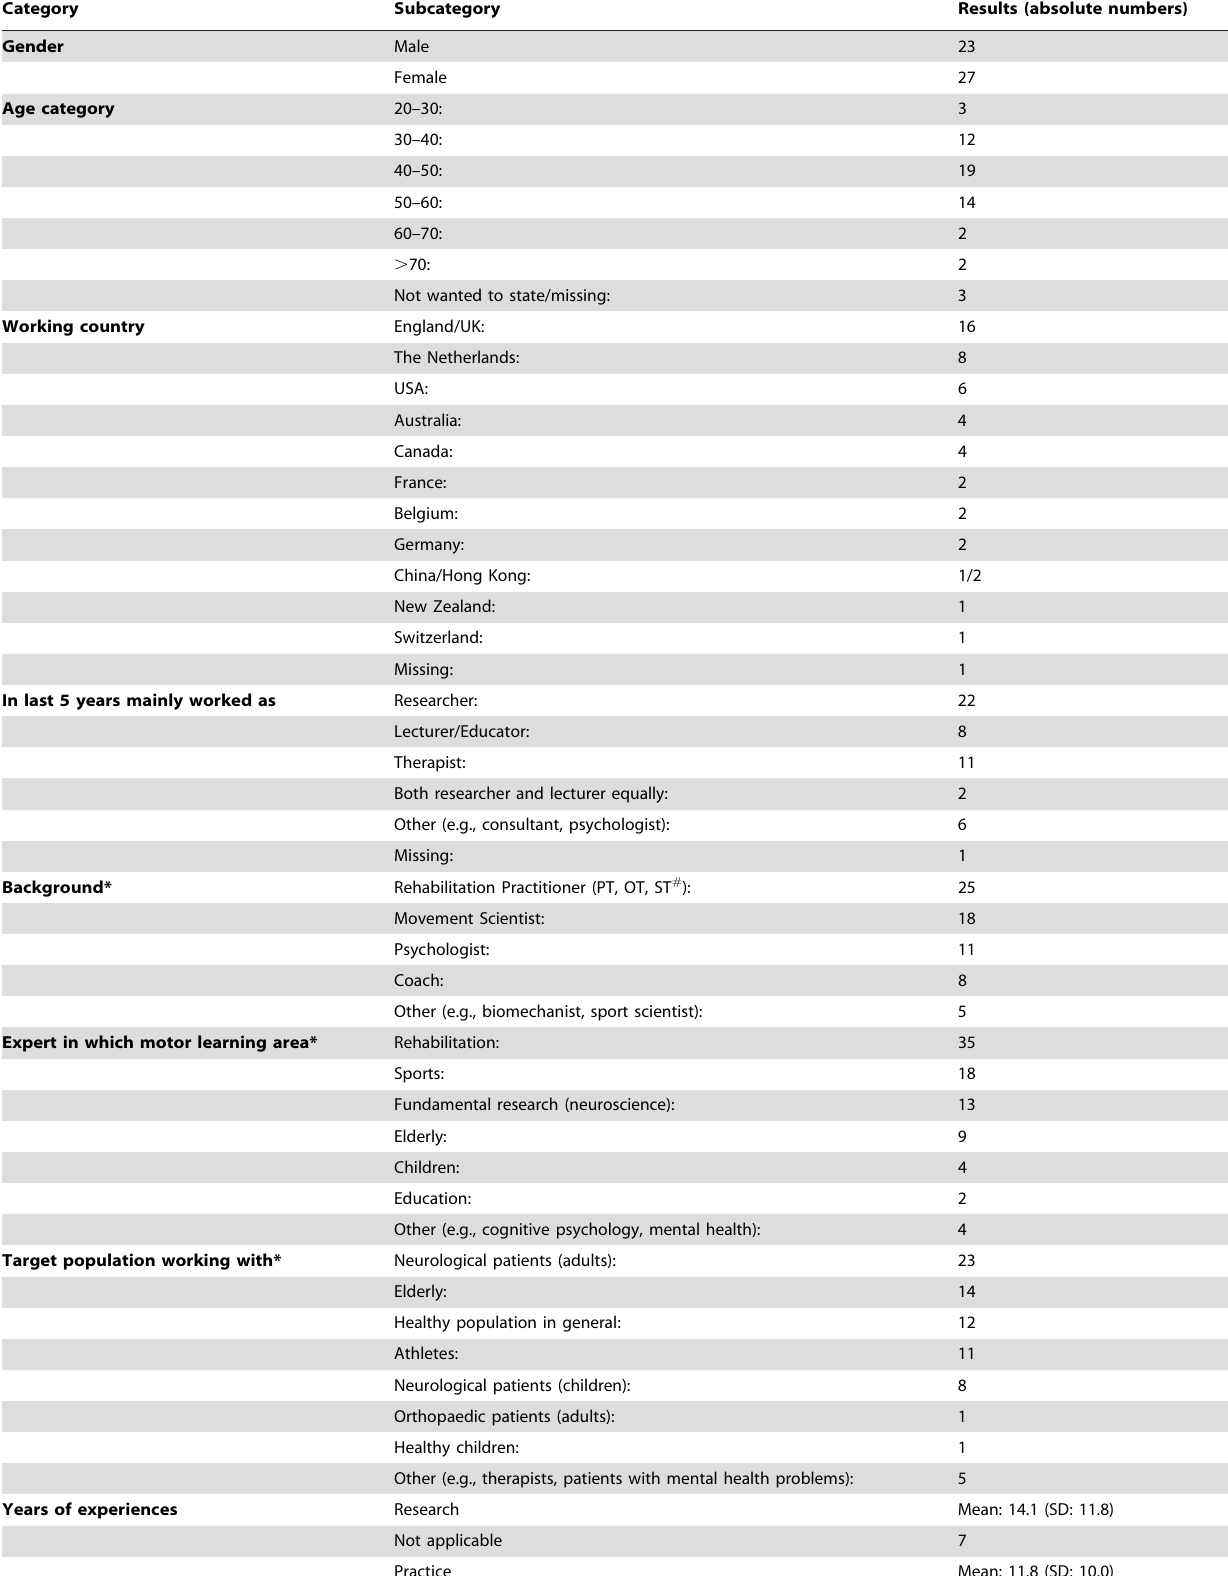
Category Subcategory Results (absolute numbers)